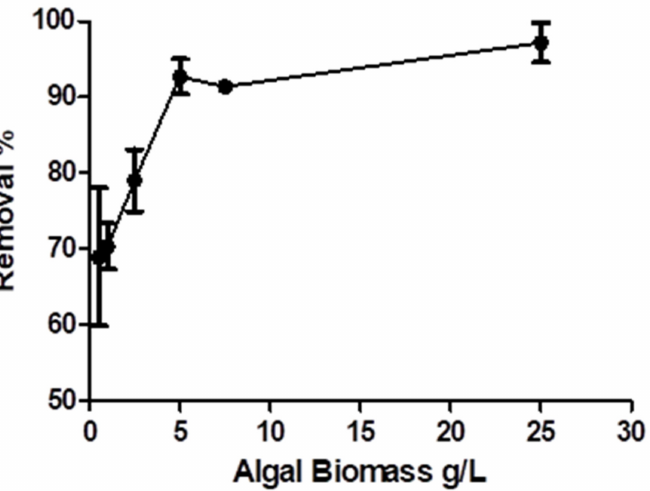
Figure 1. Influence of biomass dosage on Cd removal (initial concentration: 4 mg/L; pH: 4.0; temperature: 27 ◦ C; contact time: 24 h).